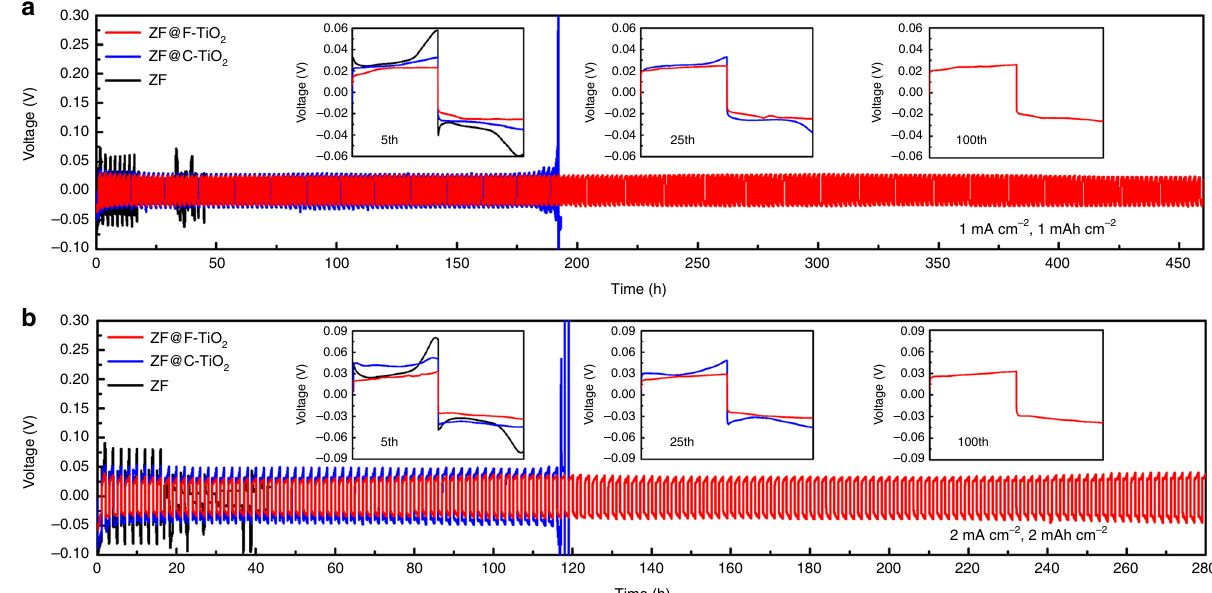
Fig. 4 Electrochemical performance of prepared Zn anodes. Cycling performance Zn – Zn symmetric cells at a 1mAcm − 2 for 1mAhcm − 2 and b 2mAcm − 2 for 2mAhcm − 2